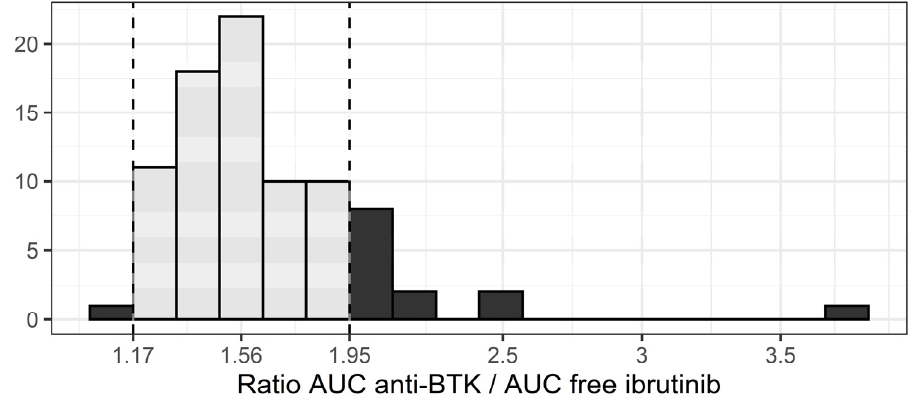
Figure 4. Distribution of the AUC ANTI-BTK / free AUC IBRU ratio (dashed lines: +/ − 25% interval around the median).